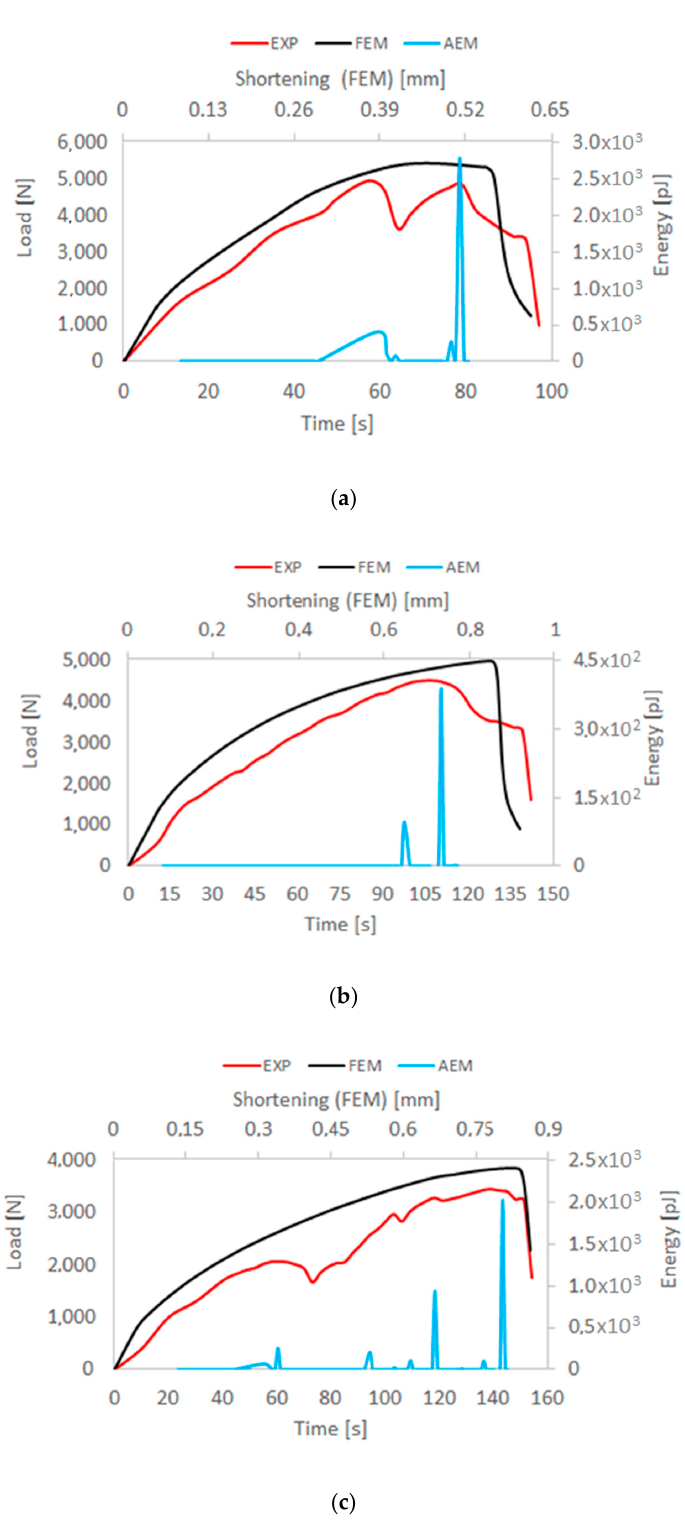
Figure 5. Comparison of the experimental and numerical characteristics of the structure (load vs. displacement): ( a ) axial compression; ( b ) eccentricity e 1 = 10 mm; ( c ) eccentricity e 2 = 6